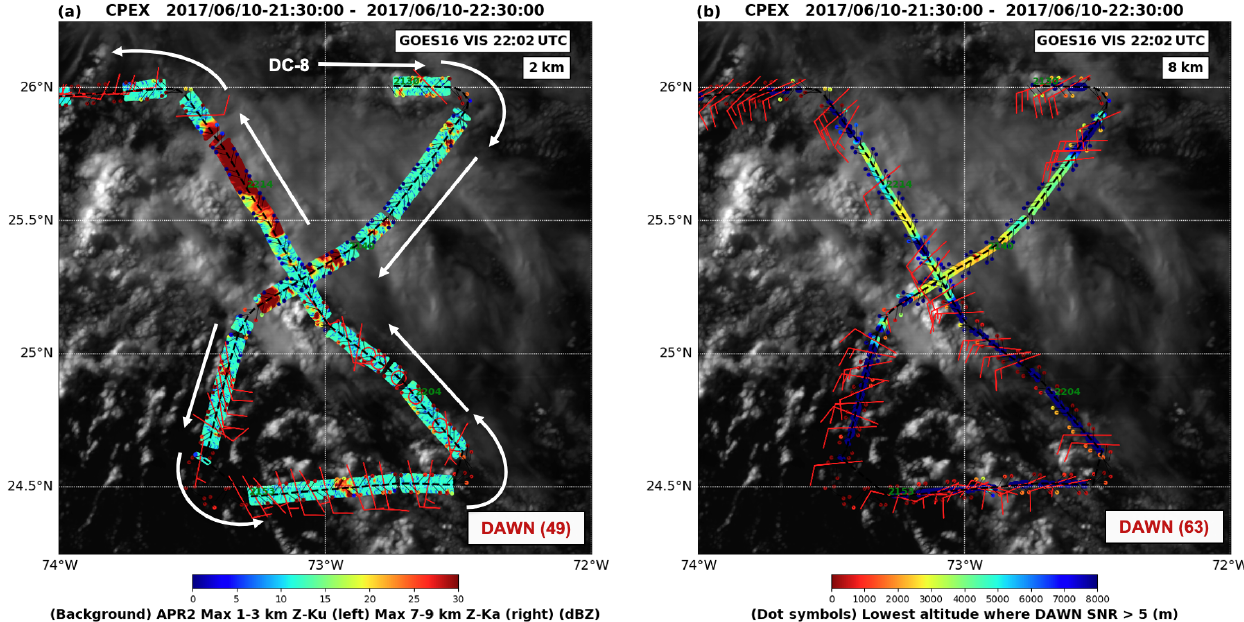
Figure 16. DC-8 flight line during segment 4 (21:30–22:30UTC) on 10 June 2017. Same layout and format as Fig. 10.